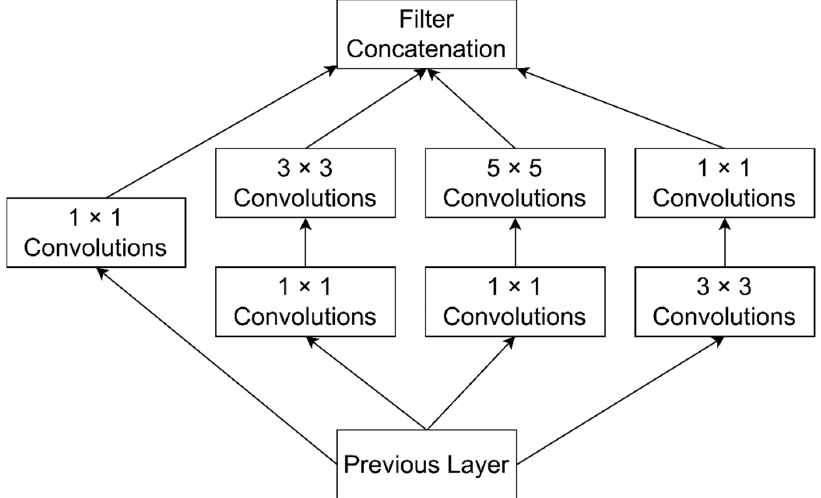
Figure 7. Inception module with dimension reduction [79].